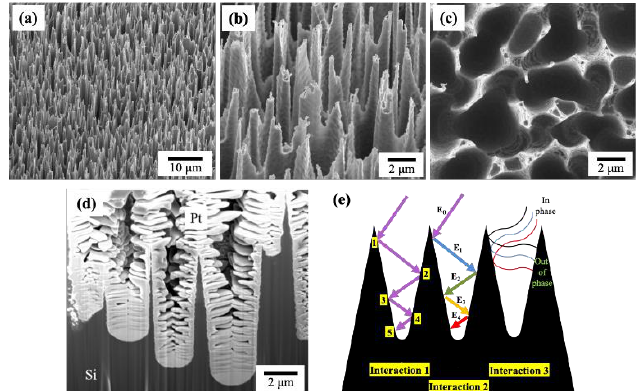
Figure 8. ( a , b ) SEM images (tilted view) of a BSi sample showing the morphology obtained after a selective etching of Si; ( c ) a top view image of the sample; ( d ) a cross-sectional view shows the sharp Si peaks and deep wells formed after the etching process; and ( e ) schematic picture showing light absorption through three interaction types. Adapted from [82] with permission from Elsevier, 2018